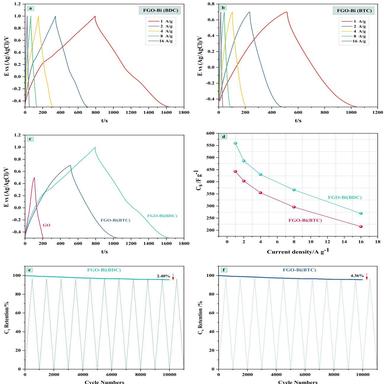
a and b) GCD curves of FGO-Bi(BDC) and FGO-Bi(BTC); c) Comparison of GCD curves for FGO-Bi(BDC), FGO-Bi(BTC), and GO at 1 A g-1; d) Comparison of the Cs of two as-synthesized composites at different current densities; e and f) Cyclic stability diagram of FGO-Bi(BDC) and FGO-Bi(BTC) over 10,000 cycles at 8 A g-1.